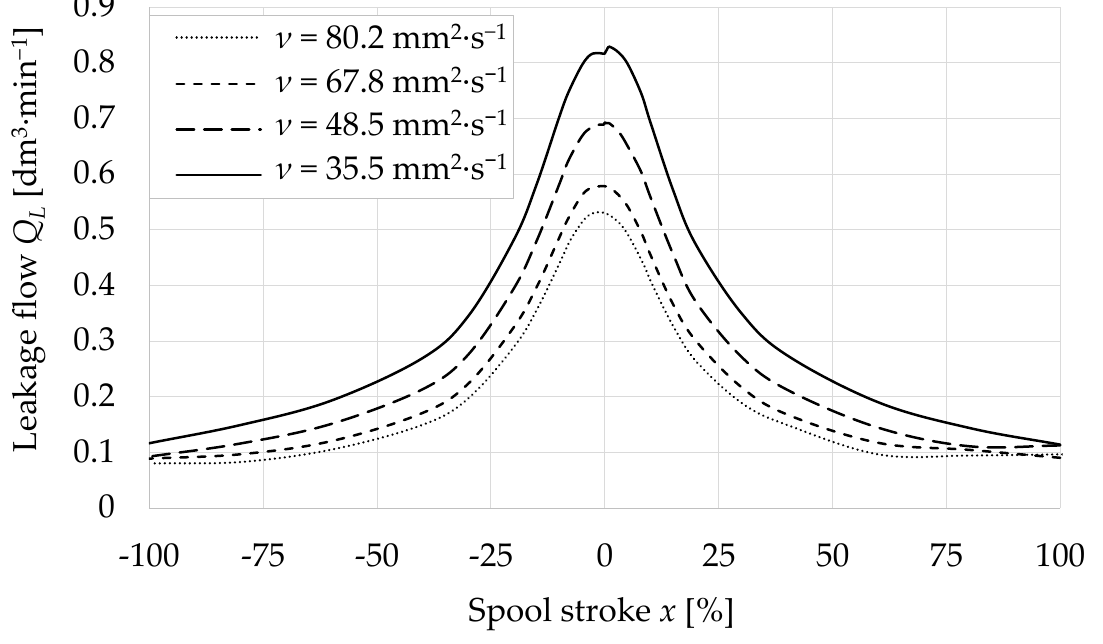
Figure 9. Leakage curves for supply pressure p P = 250 bar and different oil temperatures.